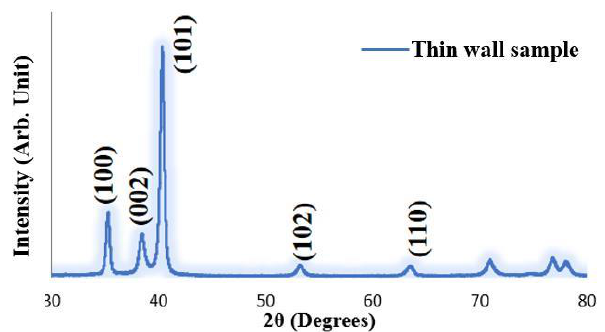
Figure 7. The X-ray diffraction pattern of the thin-wall as-built sample.